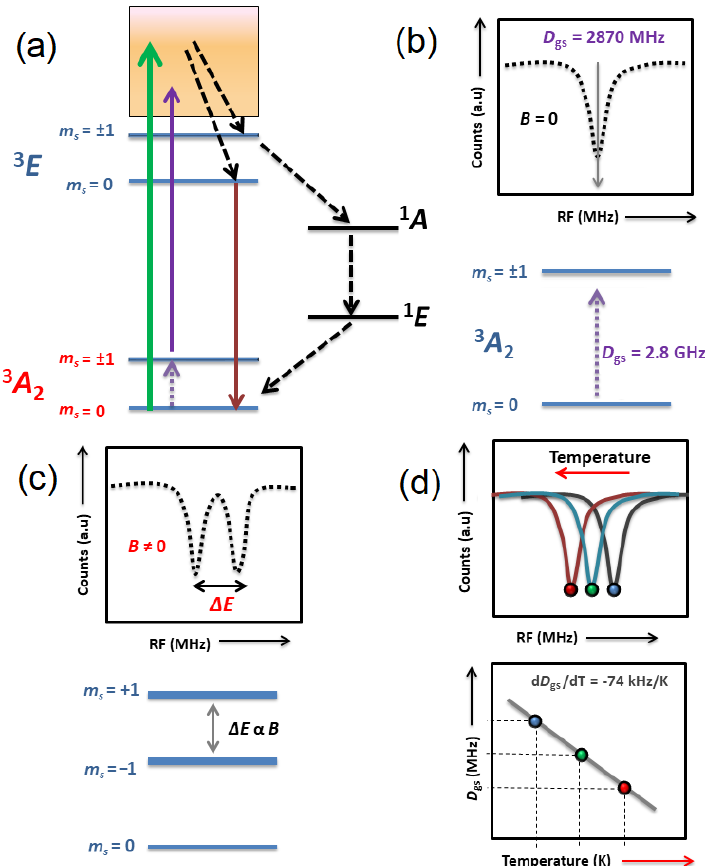
Figure 2. Electronic structure of NV center and magnetic interaction. ( a ) Schematic of the energy levels of NV center, depicting optical excitation and relaxation. Intersystem crossing through singlets states ( 1 A , 1 E ) is shown in black arrows and the resonant microwave excitation is purple. ( b ) The ODMR spectra at zero field ( B = 0). ( c ) The ODMR spectra at ( B ≠ 0) displaying the Zeeman splitting between the spin sublevels. ( d ) Thermally induced shift in the position of D gs .